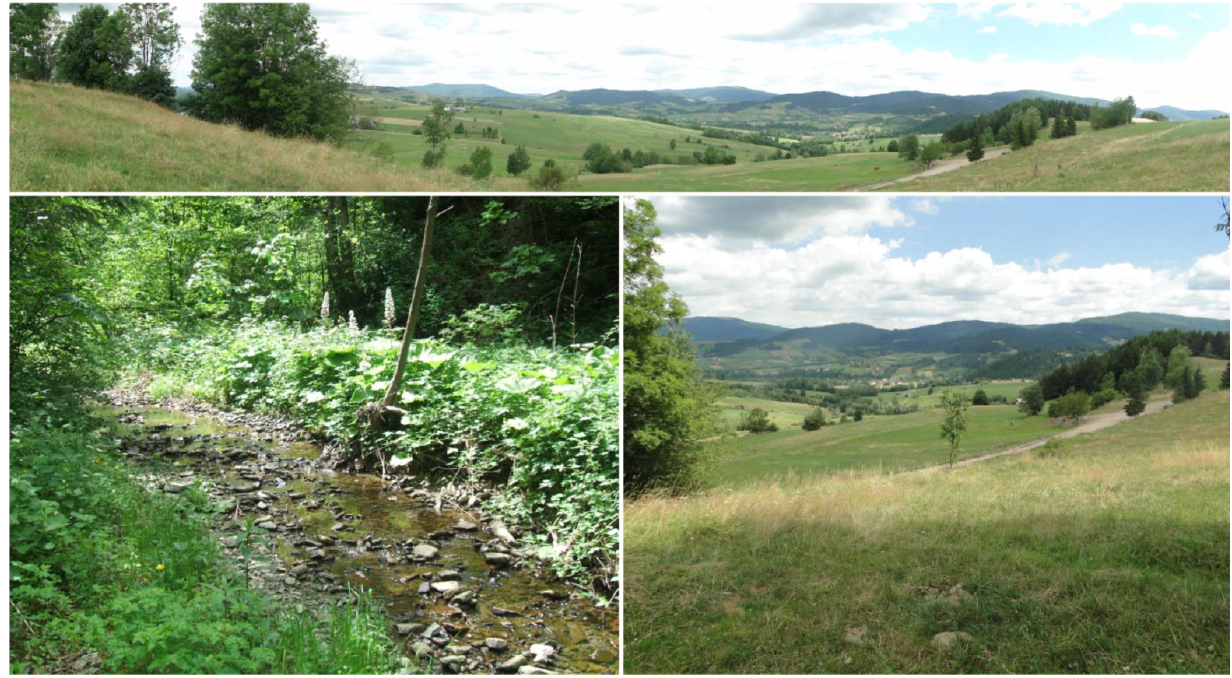
Figure 2. Photos showing typical land use of the Mątny basin.